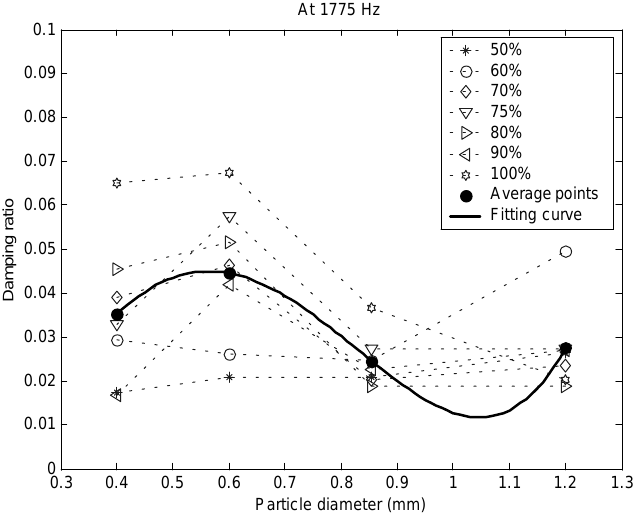
Fig. 12. Damping ratio vs. particle diameter for different packing ratios at 1775 Hz.